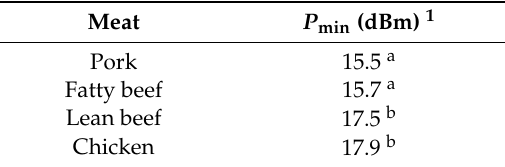
Table 7. Meat type factor effects. The mean values of the minimum power necessary to activate the tag ( P min (dBm)) are reported for each of the considered meat types in the 2.50–18.75 mm tag-to-meat distance range.